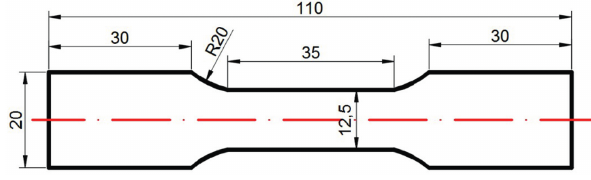
Figure 2: The dimensions of specimen used in uniaxial tensile tests (unit: